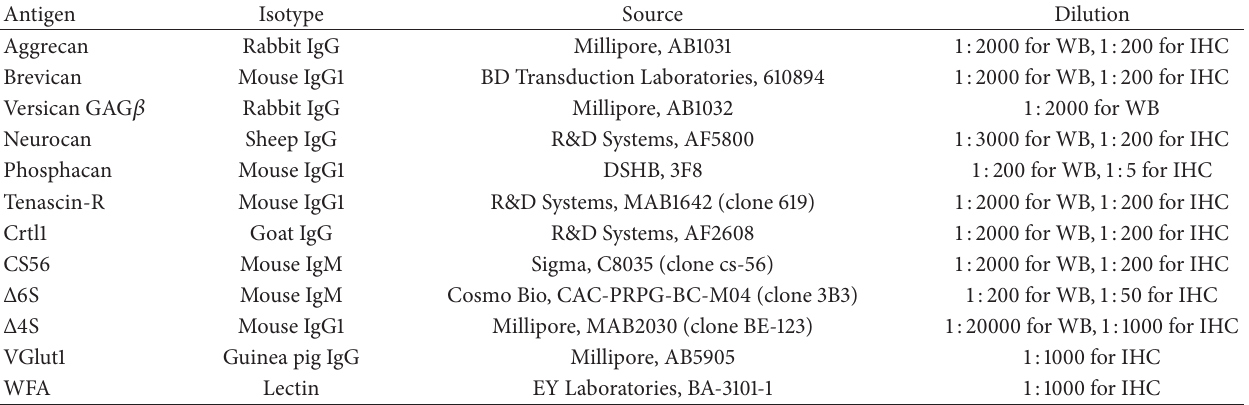
Table 1: List of the antibodies used in this